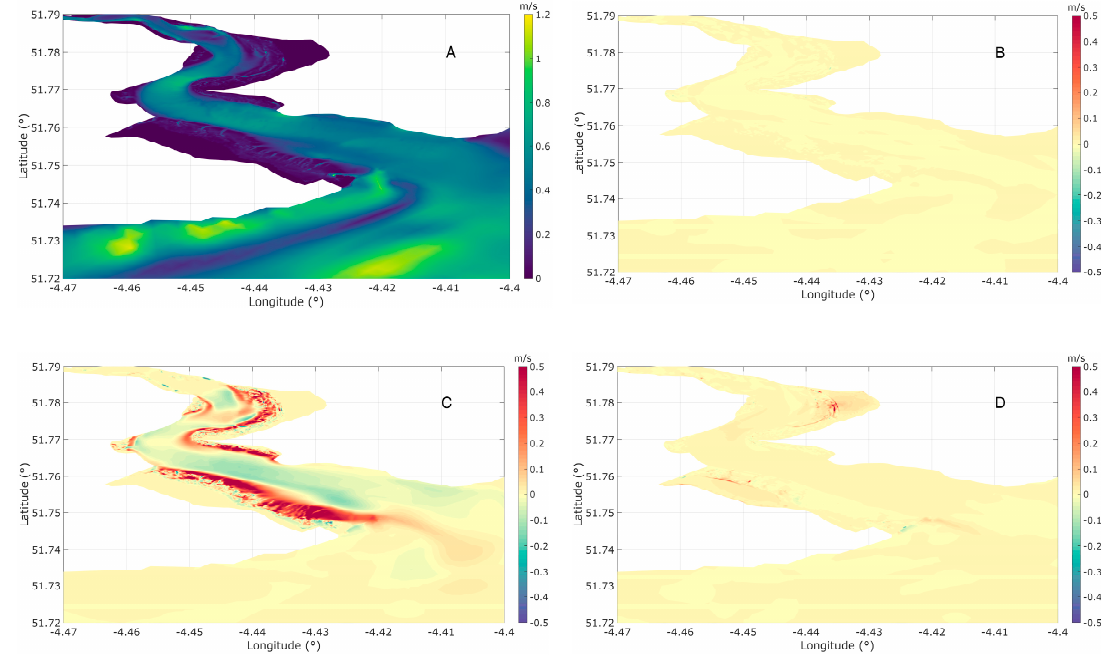
Figure 14. Comparison of peak ebb current magnitude during the 1:50 year south ‐ westerly storm. ( a ) Current condition, ( b ) difference between defended and current condition, ( c ) difference between grazed and current condition, and ( d ) difference between managed realignment and current condition. It should be noted that, in the case of south-westerly storms, the predominant wind direction is also from the south-west. Therefore, most waves on the marsh may be locally